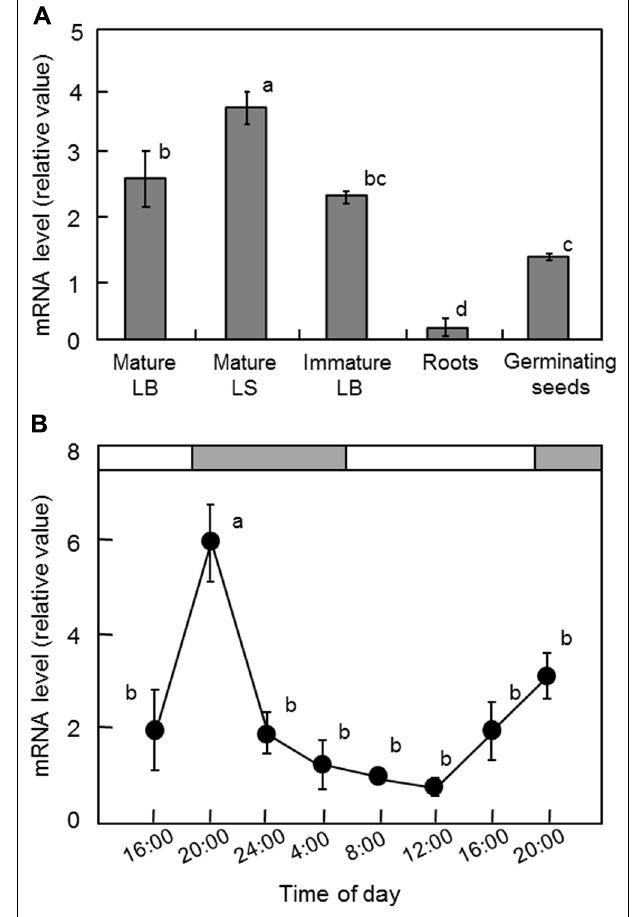
FIGURE 4 |Transcript levels of OsGWD1 in rice seedlings. Tissue-specific accumulation pattern (A) and diurnal changes in leaf blades (B) , with respect to the mRNA levels of OsGWD1 were examined by quantitative RT-PCR analysis.Values are standardized to the expression level of a rice polyubiquitin gene (% RUBIQ1 ). Data represent the mean ± SE ( n = 4) and the different letters indicate significant differences ( p < 0.05,Tukey’s test). LB, leaf blade; LS, leaf